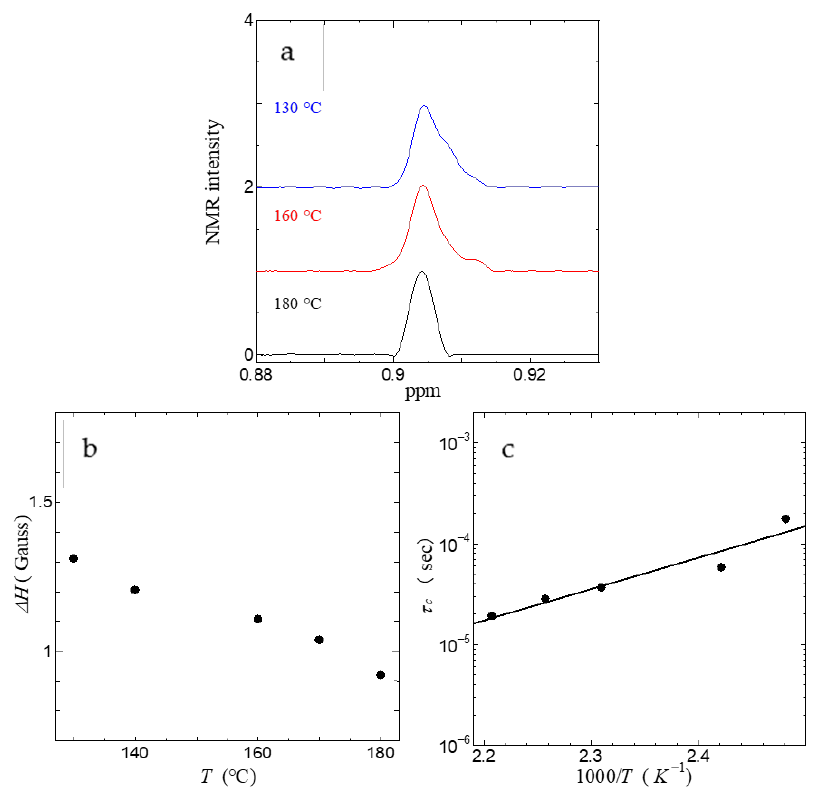
Figure 7. 1 H-NMR analysis of HAp-collagen composite films. ( a ) 1H-NMR lines of the HAp-collagen composite film at various temperatures. ( b ) The relationship between the second moment of the NMR spectra of composite film and temperature. ( c ) The relationship between correlation time and temperature of protons in the composite film.